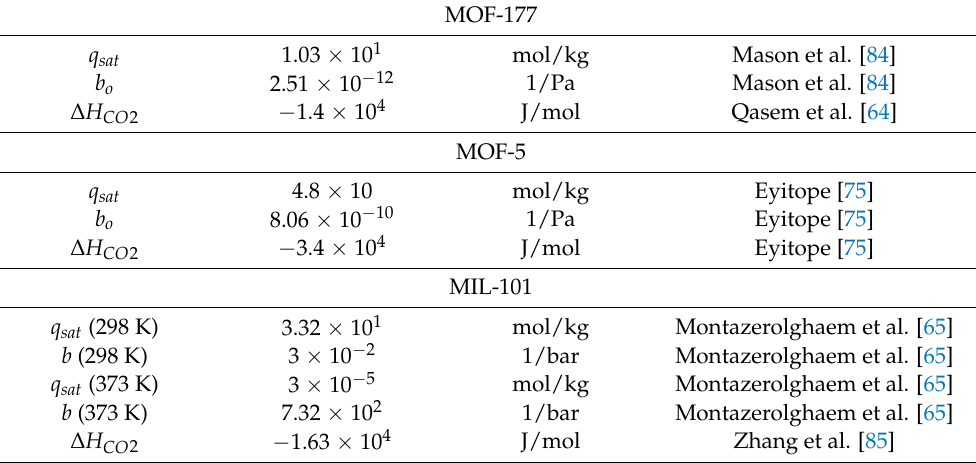
Table 7. Langmuir parameters for MOF